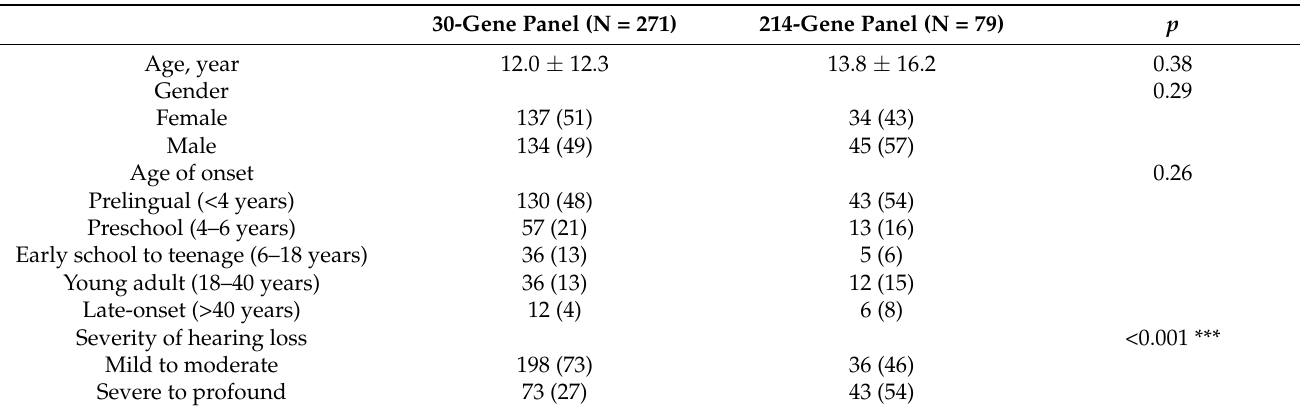
Table 3. Clinical features of patients tested with different panels.